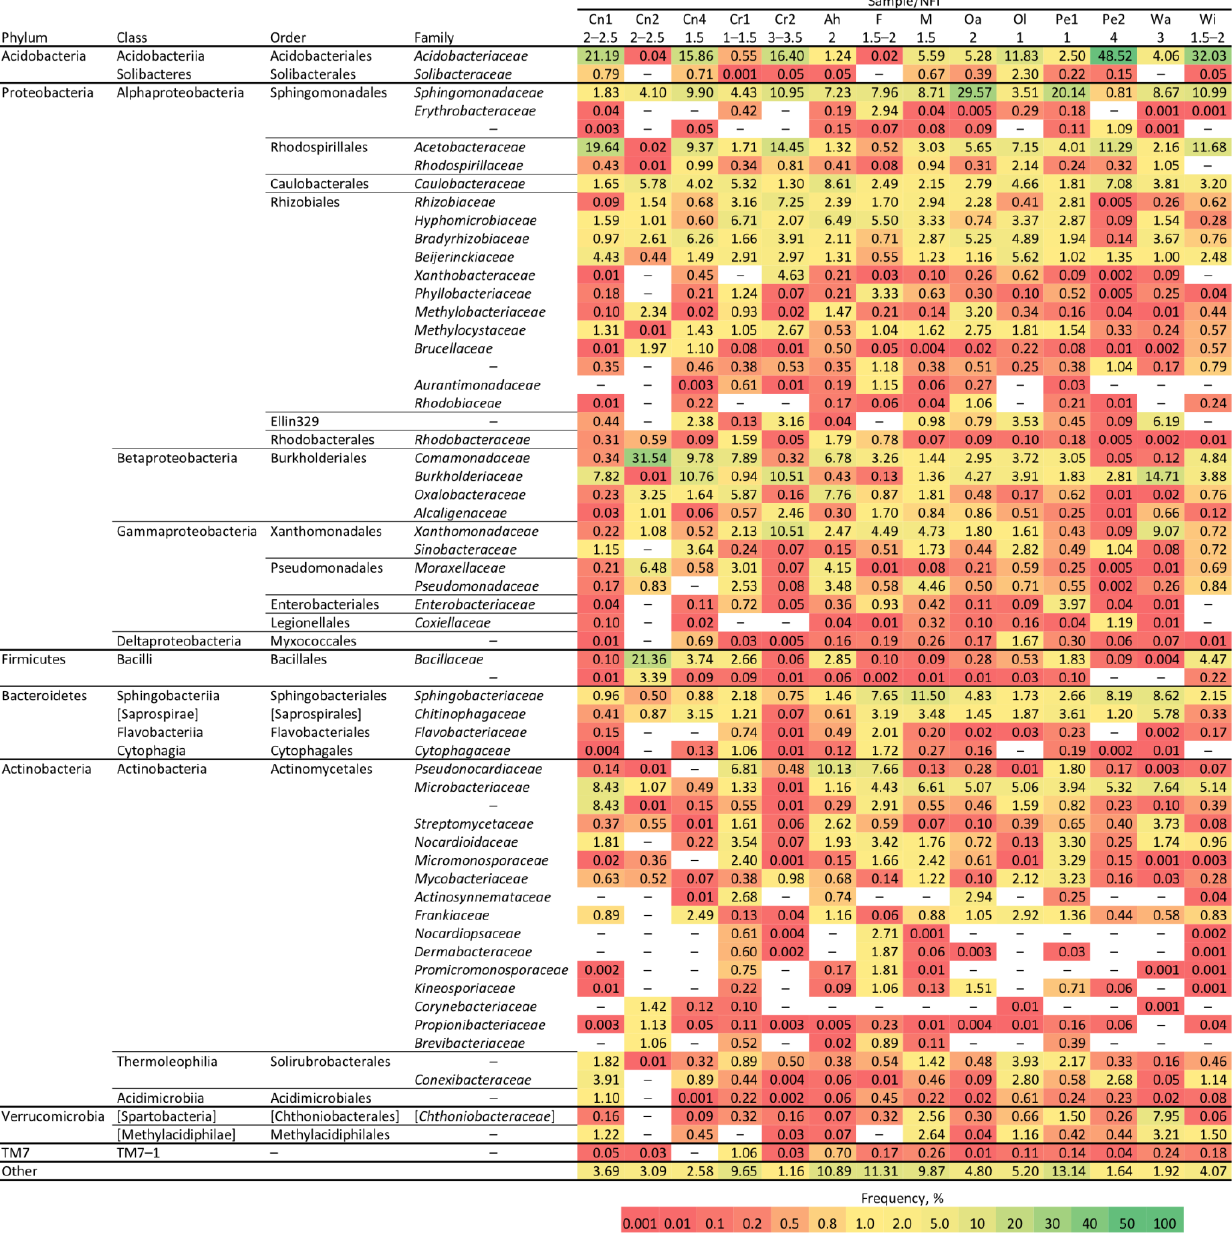
Figure 2. OTU taxonomic analysis at the family level of the bacteria of rotting wood samples. The numbers above the graphic (headed) reflect Swedish National Forest Inventory (NFI) levels (1, low level of decay; 4 high level of decay), whereas the letters indicate the code that was given to the analysed sample (see Figure 1 and Supplementary Table S1). The numbers inside the coloured boxes are frequency percentage of the appearance of a certain family in the sample. The bottom colour scale presents the frequency range of appearance.